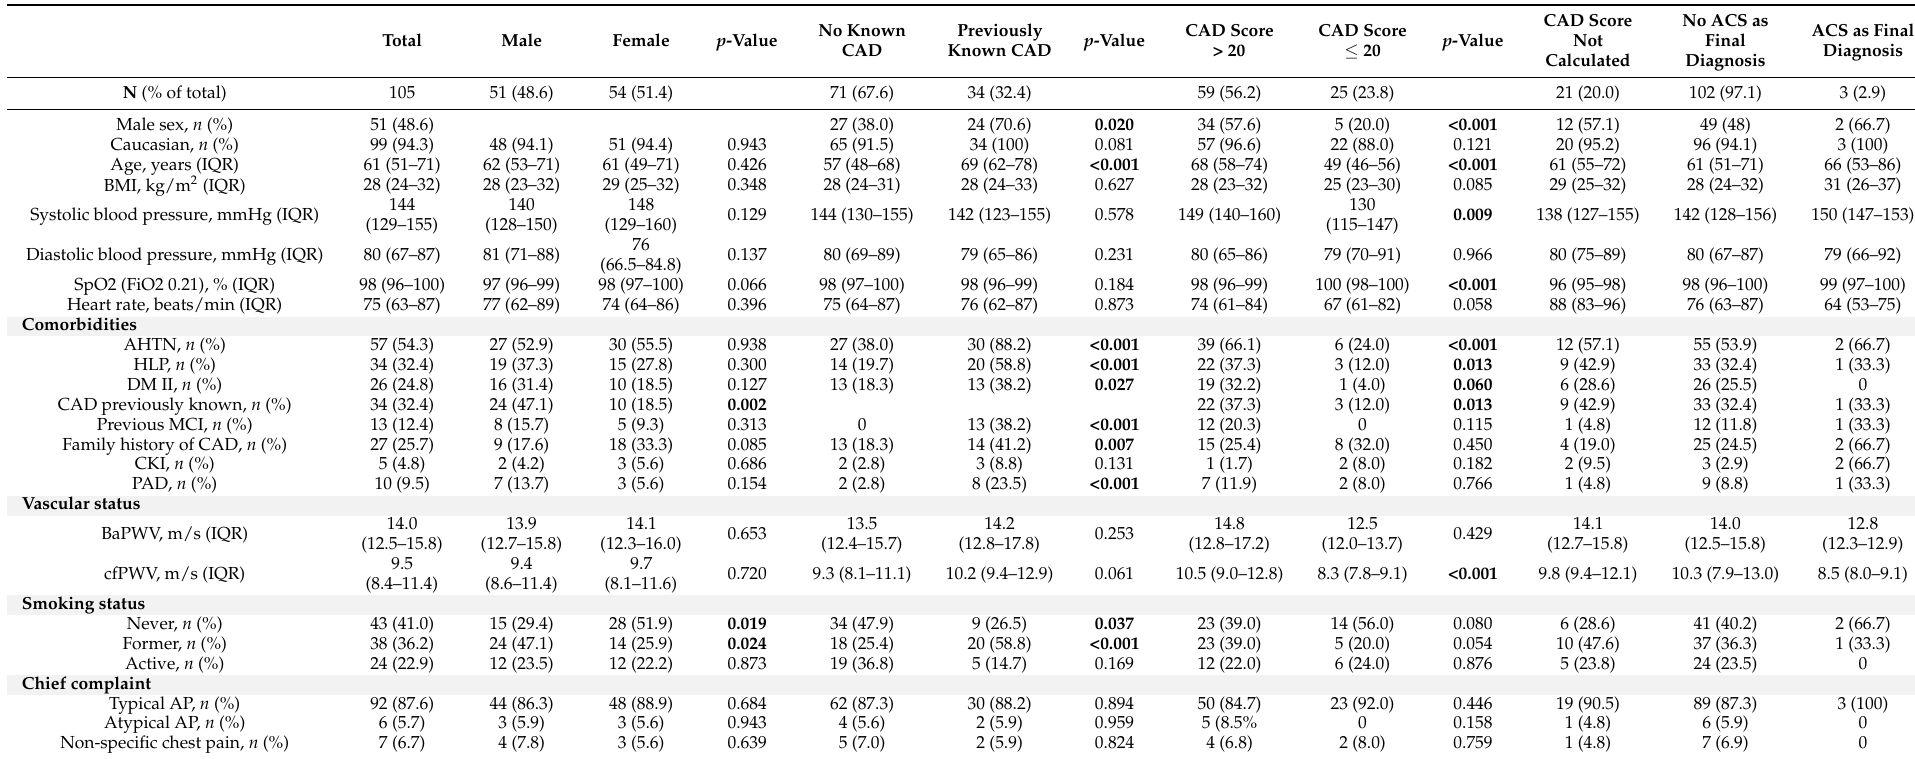
Table 1. Patient’s demographics, including chronic conditions and details of their current episode of chest pain. Values are given for the total study cohort and subgroups concerning gender, known coronary artery disease (CAD), calculated CAD score, and final diagnosis regarding acute coronary syndrome (ACS). Categorical data are presented as counts and percentages, continuous data as medians and interquartile ranges (IQRs). Categorical data are analyzed using a test for linear association (Maentel–Haenszel chi-square test), continuous data using Kruskal–Wallis test for testing within the subgroups. BMI = body mass index; SpO2 = oxygen saturation; FiO2 = fraction of inspiratory oxygen; AHTN = arterial hypertension; HLP = hyperlipidaemia; DM = diabetes mellitus; MCI = myocardial infarction; CKI = chronic kidney injury; PAD = peripheral artery disease; baPWV = brachial-ankle pulse-wave velocity; cfPWV = carotid-femoral pulse-wave velocity; AP = angina pectoris; HEART = History, ECG, Age, Risk factors, and Troponin; GRACE = Global Registry of Acute Coronary Events; NYHA = New York Heart Association; ECG = electrocardiogram; IMCU = intermediate care